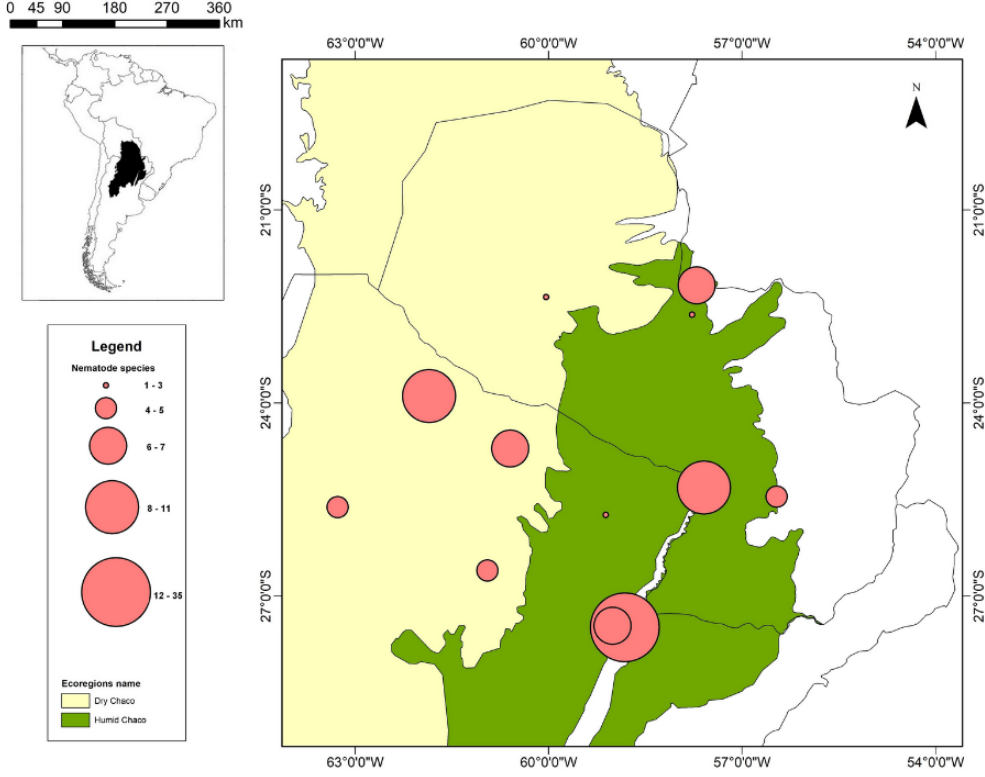
Figure 4. Number of nematode species found in each locality in Dry and Humid Chaco. Corrientes: Aplectana delirae , A. hylambatis , Aplectana sp., Brevimulticaecum sp., Camallanus sp., Contracaecum sp., Cosmocerca cruzi , C. parva , C. podicipinus , C. rara , Cosmocerca sp., Cosmocercella minor , Cosmocercoidea gen. sp., Falcaustra mascula , Gyrinicola chabaudi , Gyrinicola